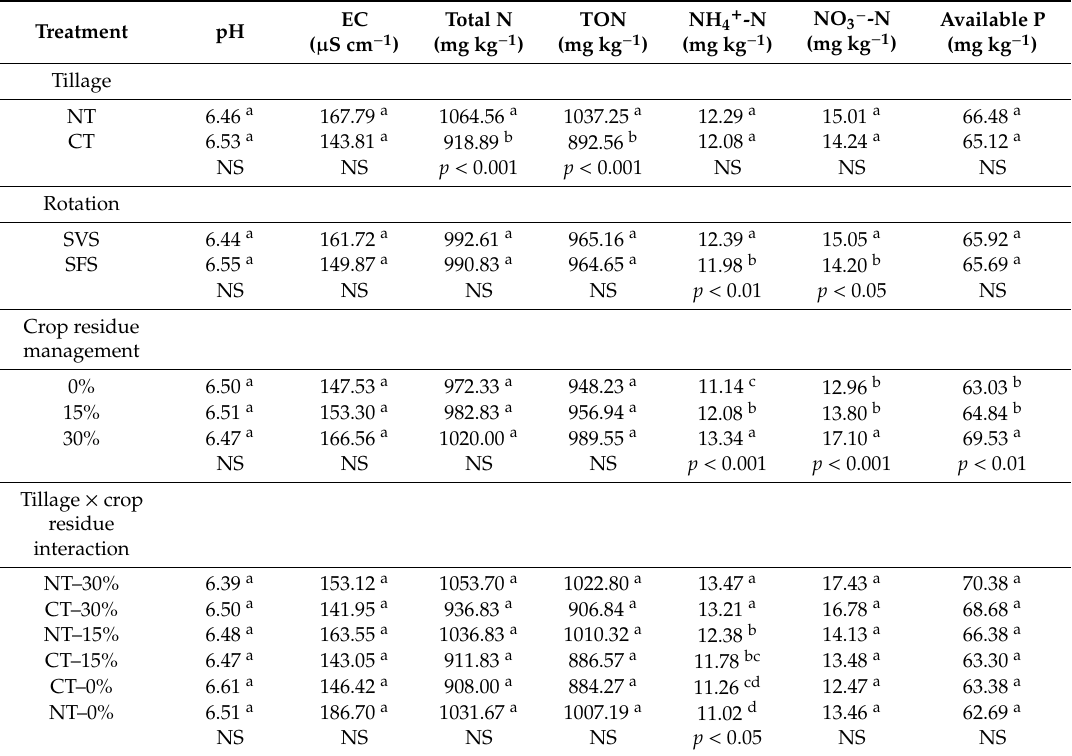
Table 3. Mean separation results of electrical conductivity (EC), pH, total nitrogen, total